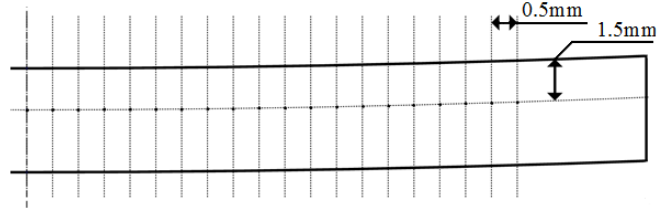
Figure 5. Measurement position of hardness.